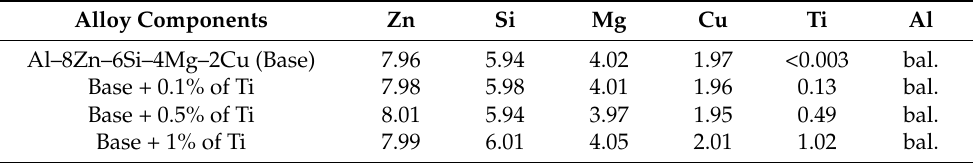
Figure 1. SEM image of the Al–5Ti–1B master alloy rod: ( a ) low magnification and ( b ) high magnification. Table 1. Chemical composition of different Al–5Ti–1B master alloy additions to the Al–8Zn–6Si–4Mg–2Cu–xTi alloys. All values are expressed in weight